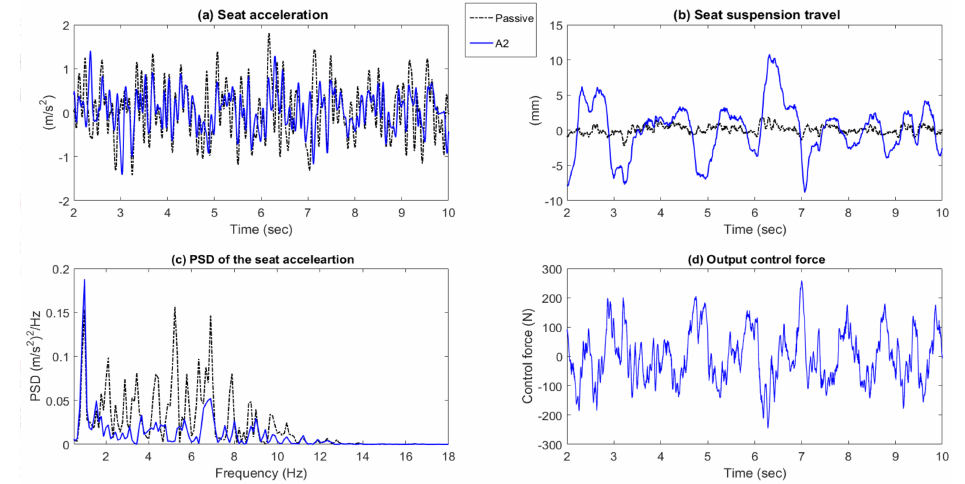
Figure 15. Time responses and PSD of the passive system and active seat suspension with controller A2.